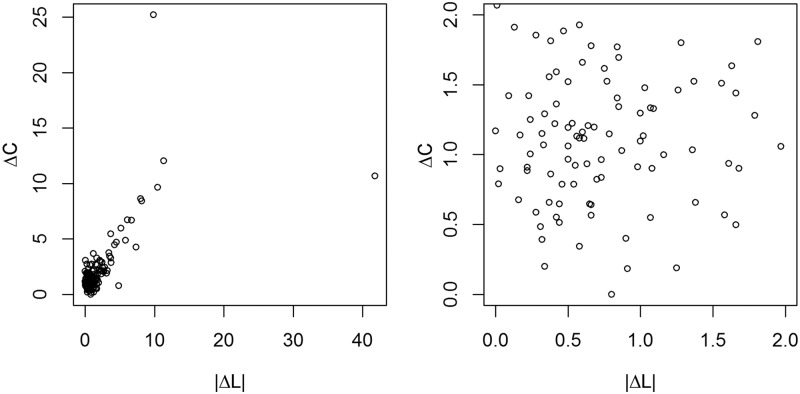
Correlation between ΔC and |ΔL|.A (left). Scatter plot of all values for ΔC and |ΔL|. The overall Spearman (non-parametric) correlation between ΔC and |ΔL| was 0.55 (p < .0001). B. (right) is an enlargement of the area near (0,0)–observations for which both ΔC and |ΔL| are less than 2. The correlation is tiny (0.06) and non-significant (p = 0.562). (ΔC = vector distance between the measured lead tip locations on serial CT scans, |ΔL| = measured change in intracranial lead length on serial CT scans).